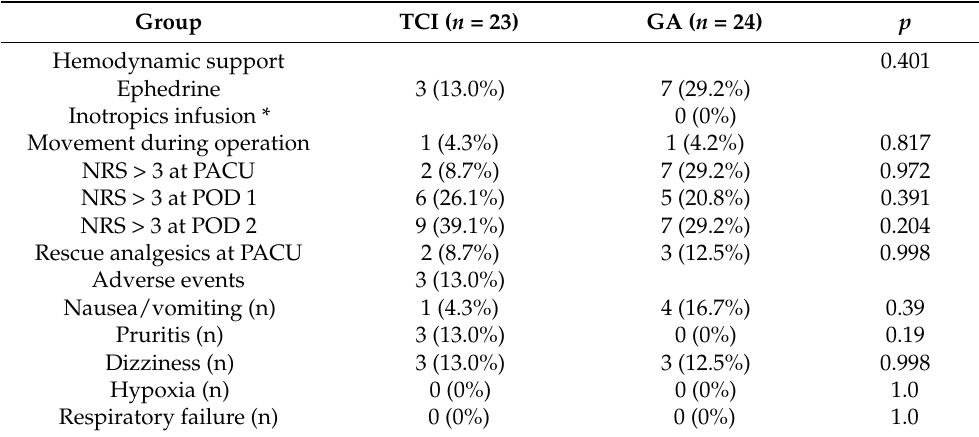
Table 2. Intra-operative events and recovery profile.